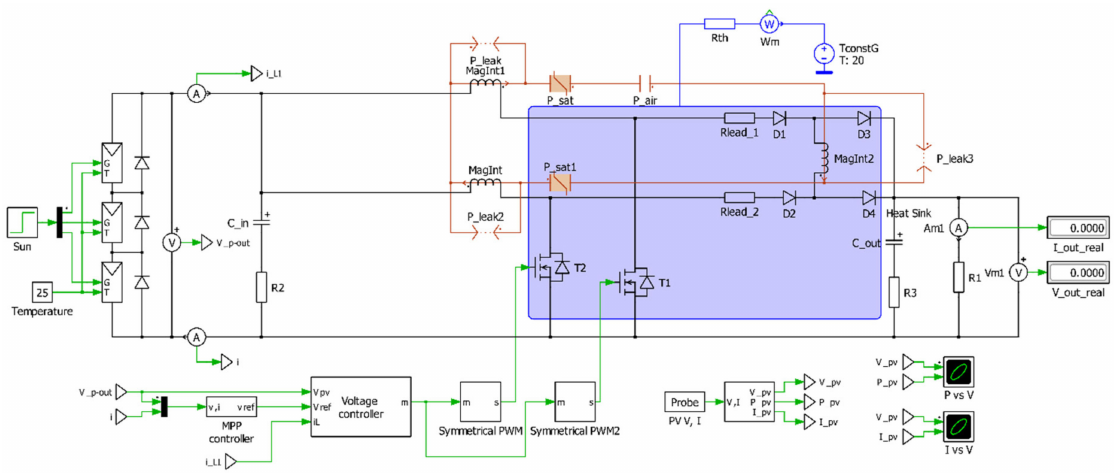
Figure 7. Simulation model of perspective MPPT converter.